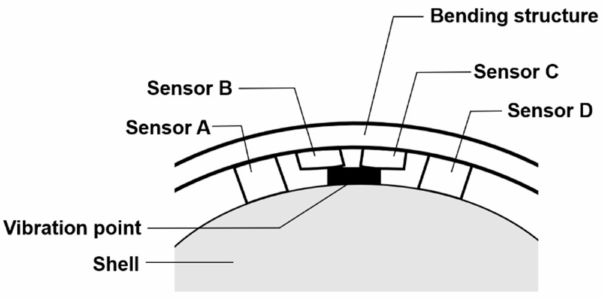
Figure 4. The mechanical structure model of the acquisition system.